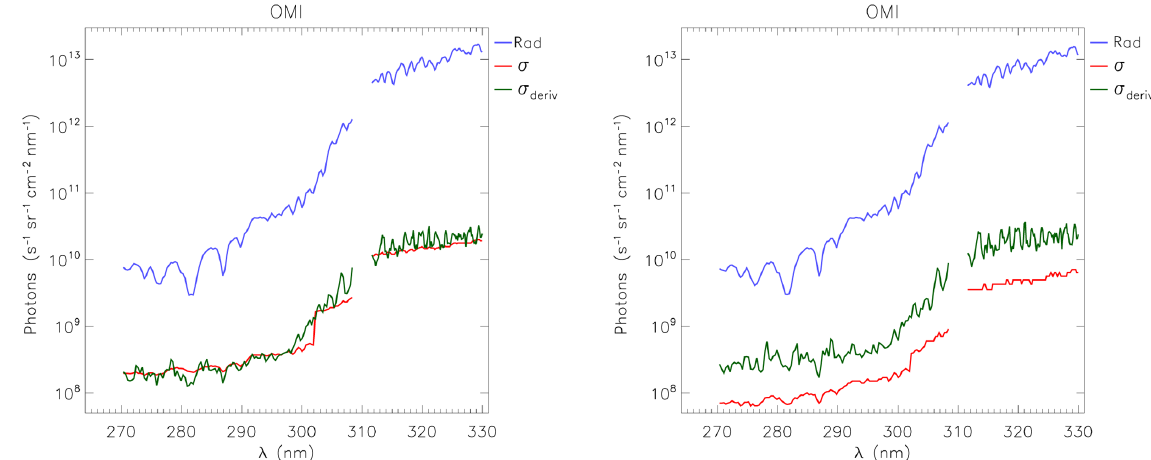
Figure 2. OMI radiance spectrum used in the retrieval, the area around 310nm is not used. The blue and red lines are the radiance and uncertainty, respectively. The green line shows the fitted standard deviations of the relative difference (see Eq. 14) multiplied by the ra- diance. Left plot before the L0 to L1b processor update: date = 25 February 2006, lon = 145 . 2 ◦ , lat =− 20 . 3 ◦ ; right plot after the update: date = 5 February 2010, lon = 138 . 0 ◦ , lat =− 28 . 0 ◦